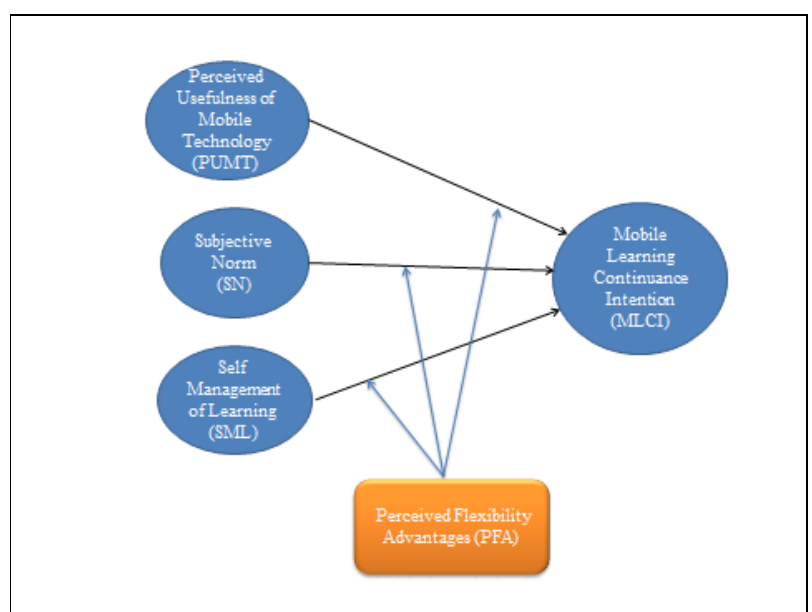
Figure 1 . Theoretical framework of the